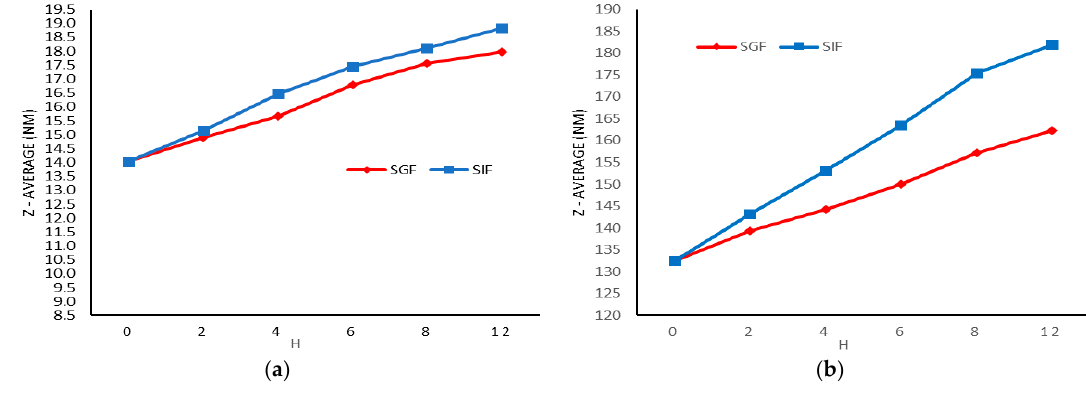
Figure 4. Particle size changes in formulation I ( a ) and formulation III ( b ) in SGF&SIF (condition C).